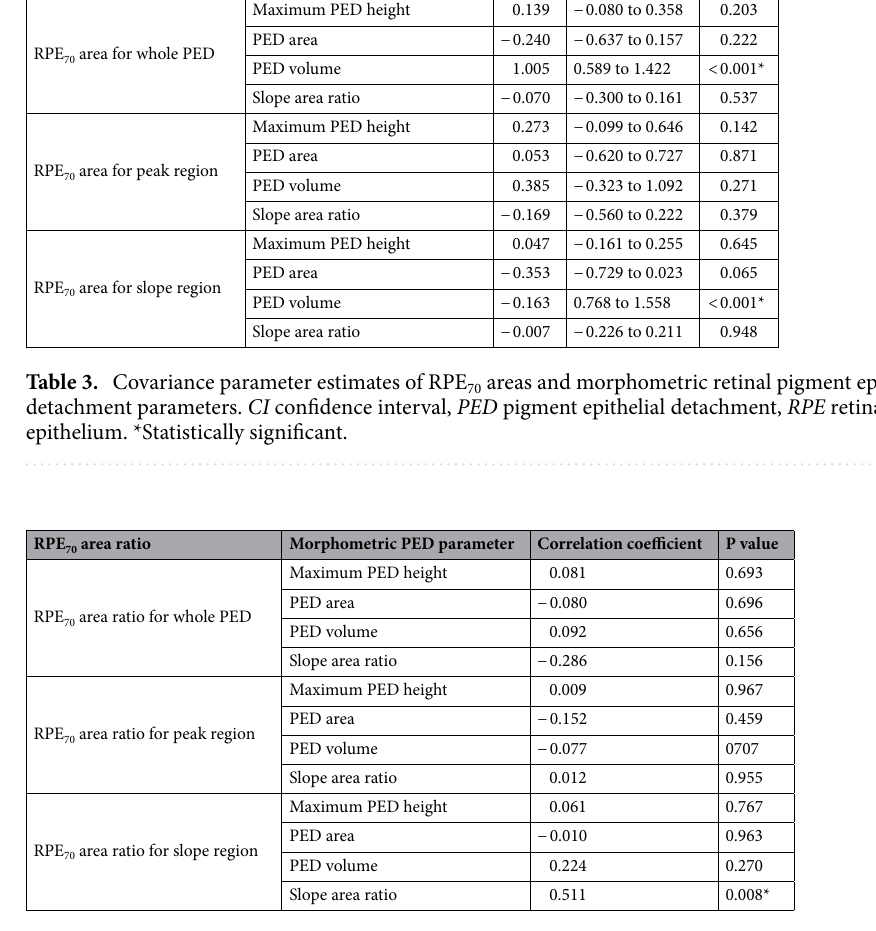
Table 4. Correlations between RPE 70 area ratios and morphometric retinal pigment epithelial detachment parameters. PED pigment epithelial detachment, RPE retinal pigment epithelium. *Statistically significant correlation.